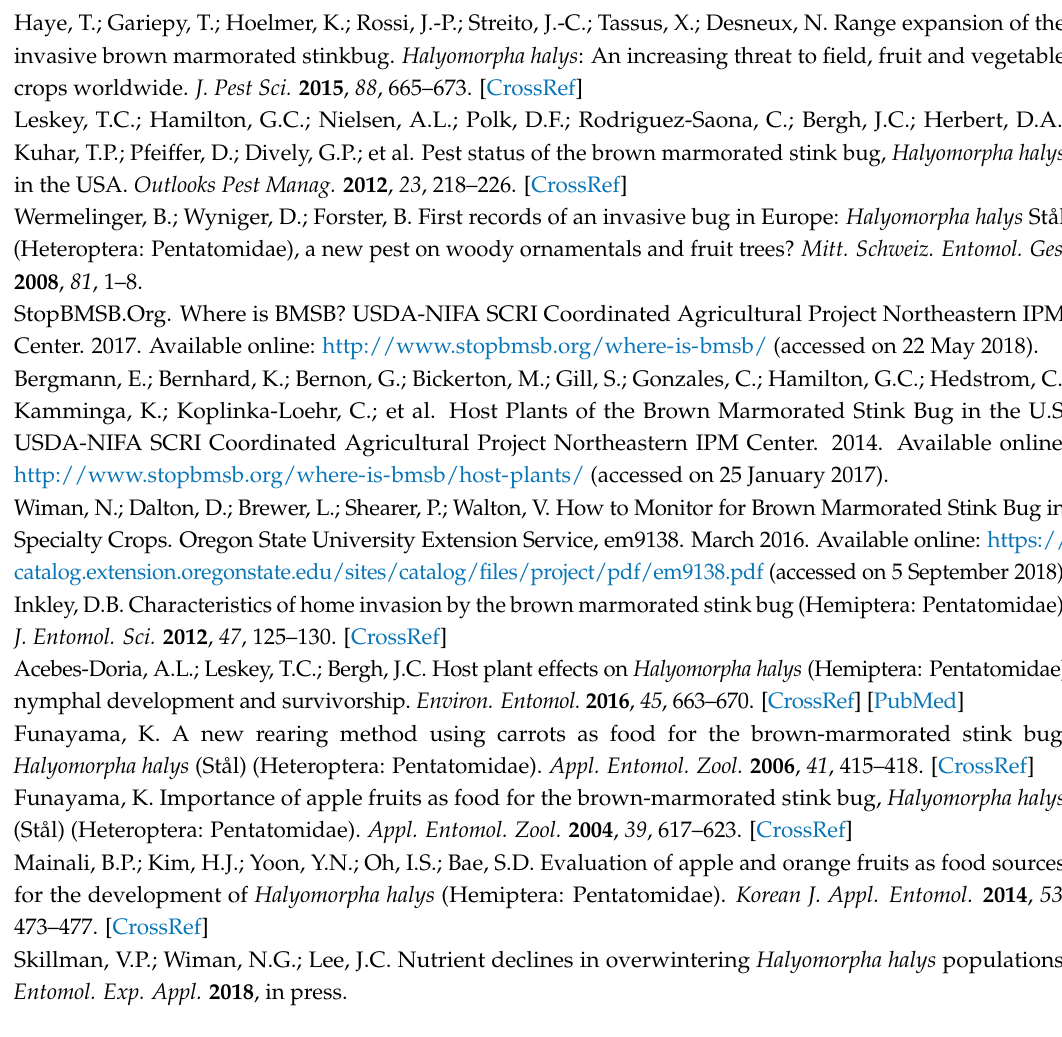
Table S1: The average nutrient level per mg ( ± SE) for adult, female and male, and nymphal BMSB. Different letters denote a significant difference between months by Tukey HSD for each nutrient-sex-year grouping (statistical outputs similar to Table 3, not shown); no statistics on nymphs. Table S2: The number ( n ) and percent (%) of females per ovarial rank (1 undeveloped, 2 reproductive mature, but not mated, 3 mated with starting of egg development, 4 high egg count with filled mature eggs, 5 post egg laid) by month and year for summer-collected BMSB. Table S3: The number ( n ) and percent (%) of female per spermathecal rank (1 unmated, 2 unsure, 3 mated) by month and year for the summer-collected BMSB, Table S4: The number of females and males collected at each of the five locations for the 2015–2016 summer collection of BMSB